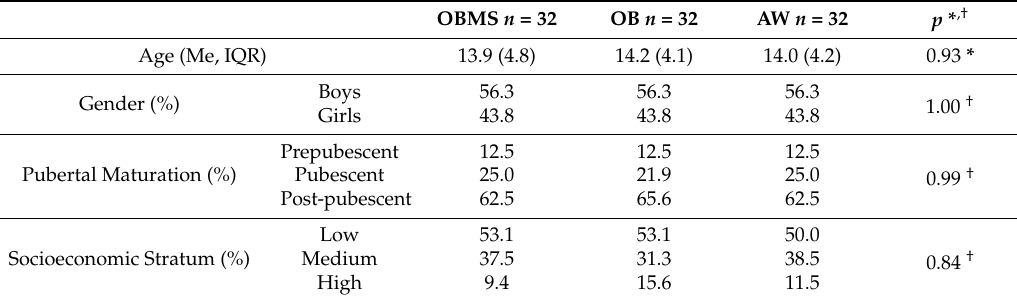
Table 1. Matched characteristics of the study